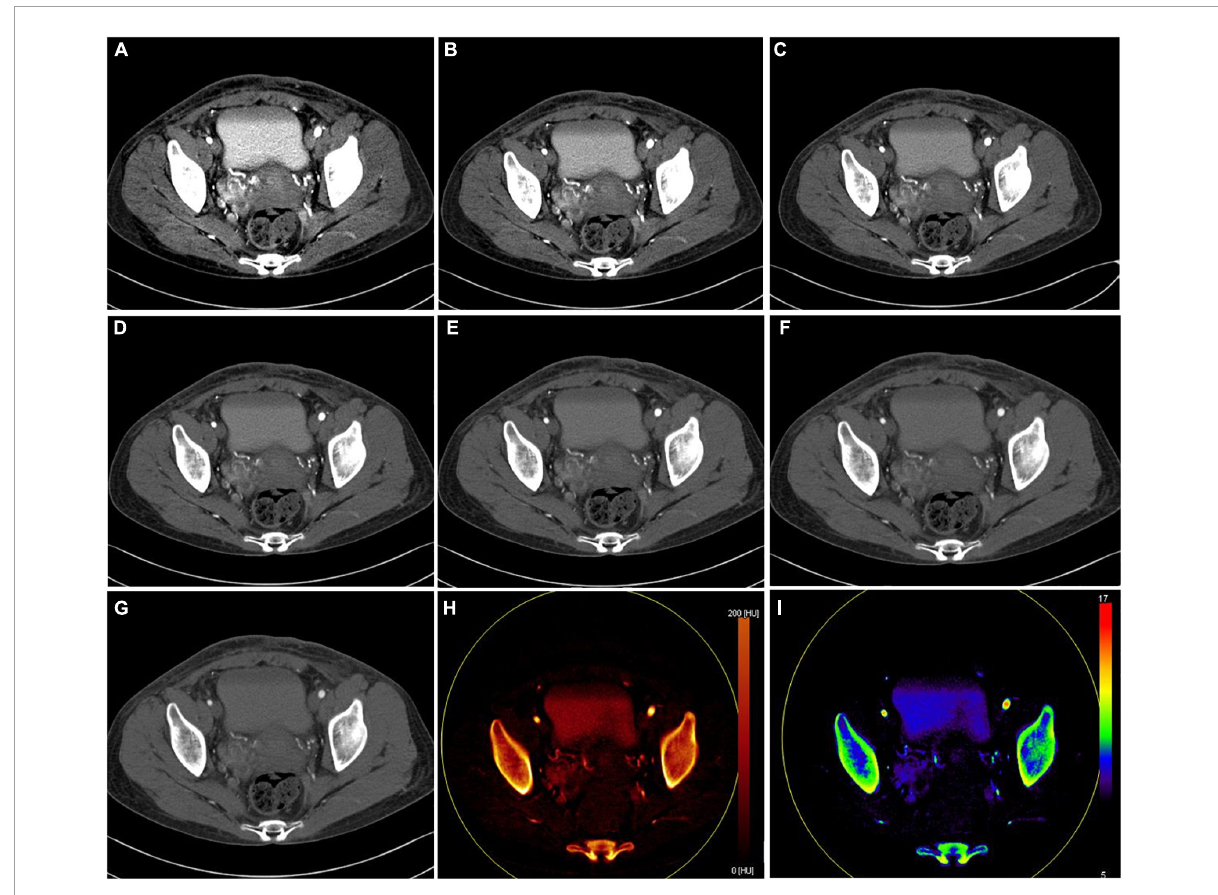
FIGURE4 Axial dual-energy computed tomography (CT) images show tortuous and enlarged paracervical veins. (A–G) 40–100 keV VMIs (10-keV interval). (H) Iodine density map. (I) Z effective